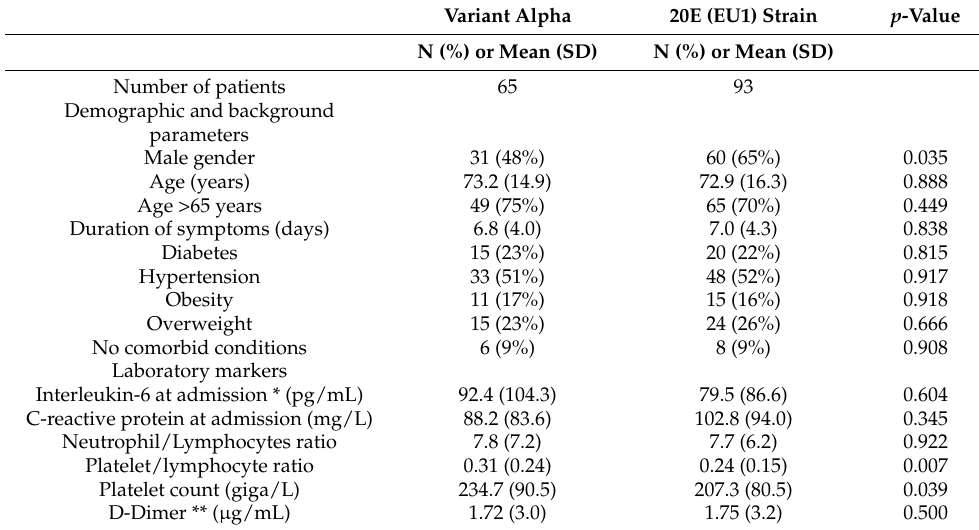
Table 1. Comparison between patients with variant alpha and wild-type